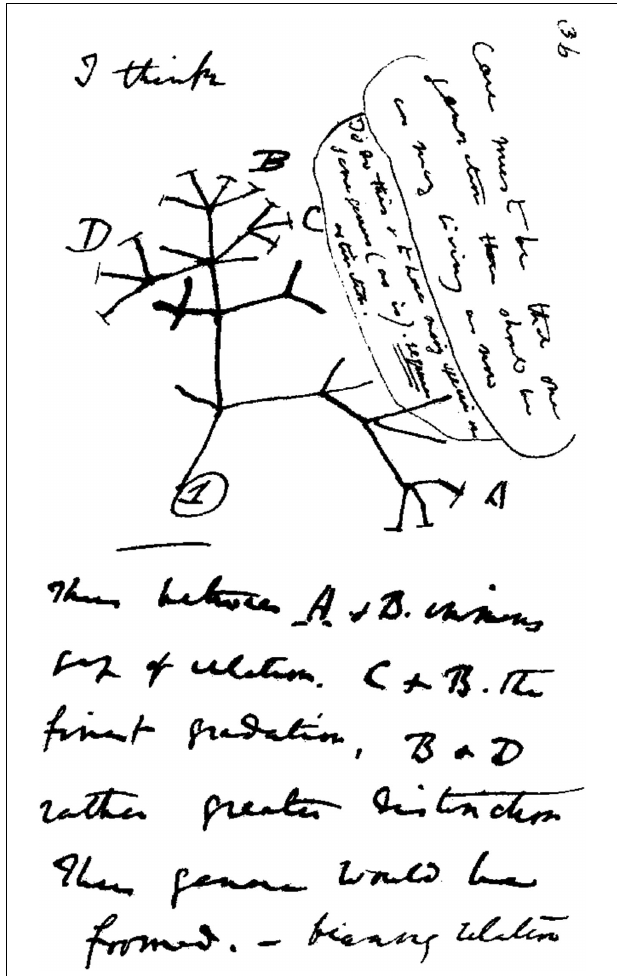
FIGURE 1 | Charles Darwin’s 1837 sketch. His first diagram of an evolutionary tree from his First Notebook on Transmutation of Species (1837). Interpretation of handwriting: “I think case must be that one generation should have as many living as now. To do this and to have as many species in same genus (as is) requires extinction. Thus between A + B the immense gap of relation. C + B the finest gradation. B + D rather greater distinction. Thus genera would be formed.” Attribution: Charles Darwin/Public